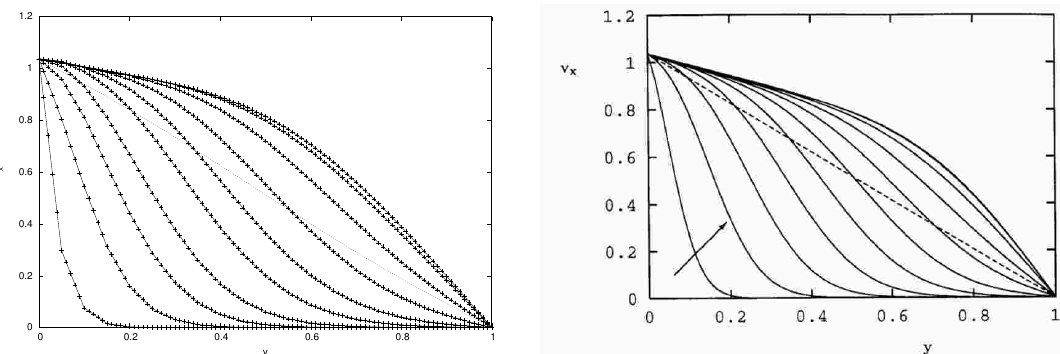
Figure 7. Evolution of the velocity profile during the inception of simple shear flow for times up to t = 1.05 using, We = 1, η S = 0.05, ξ = 0.2, Re = 1, and V = 1.037 (as compared with the analytic solution from reference [38] (RHS)). The dashed line is the final steady-state.